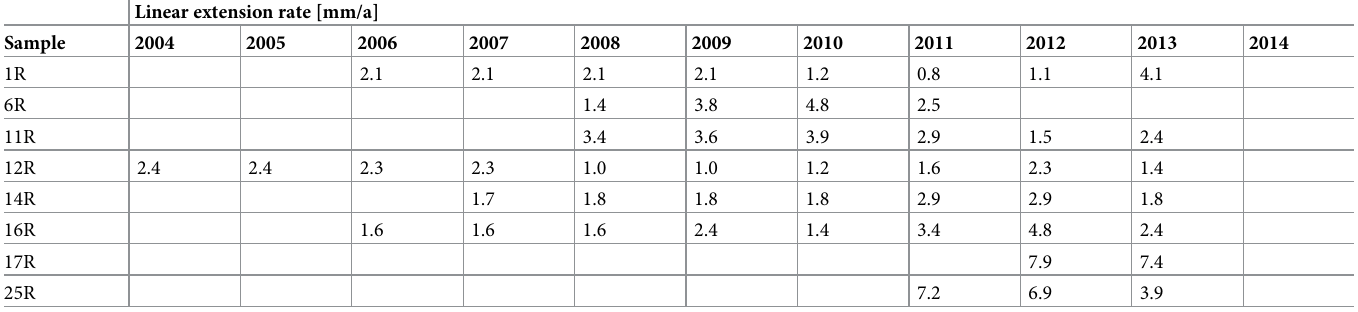
ity (weak contrast). The main growth lines described earlier, which emerge from dark areas Table 6. Linear extension